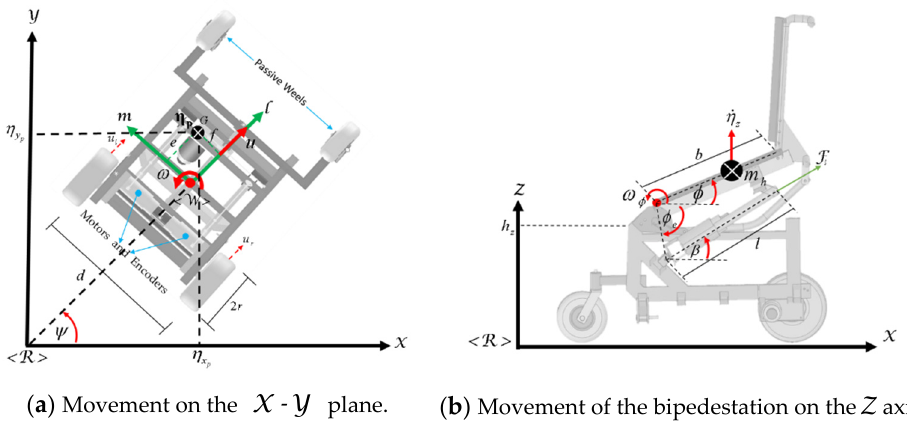
( b ) Movement of the bipedestation on the Z axis. Figure 5. Schematic of the robotic standing wheelchair. Figure 5. Schematic of the robotic standing